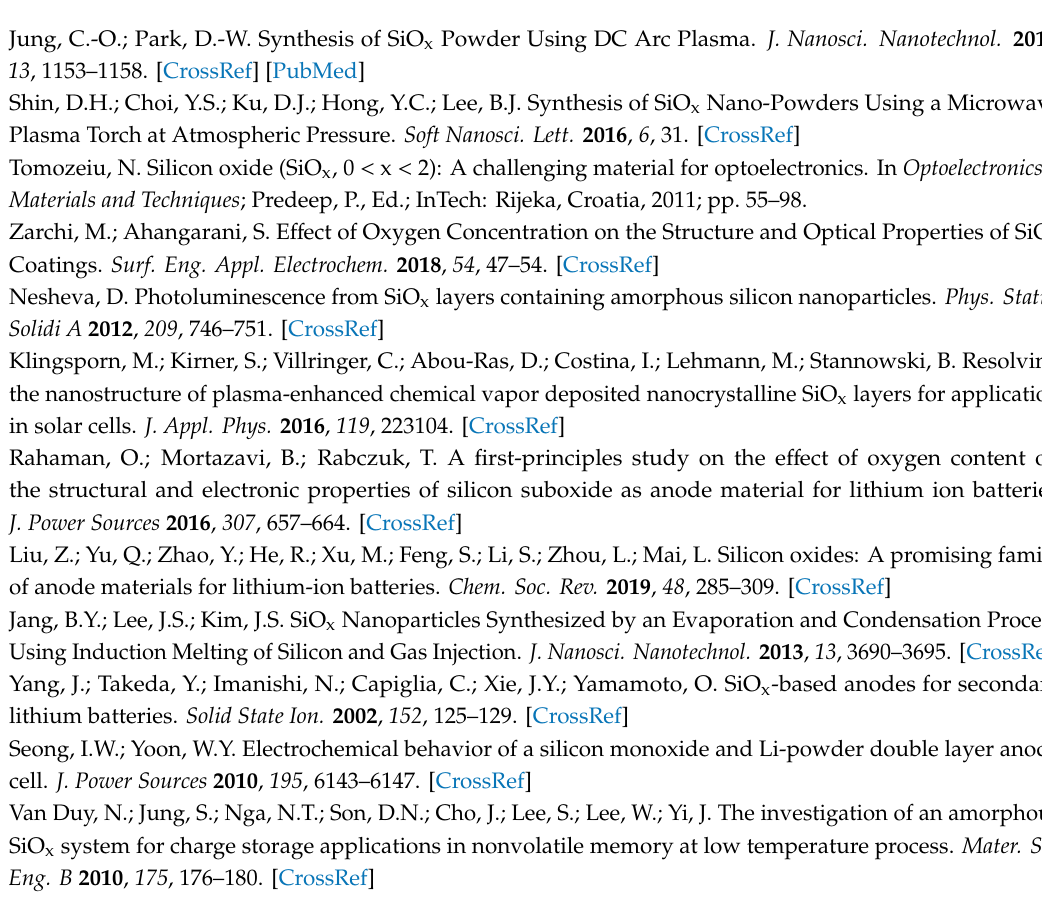
Figure S1: FESEM images and their high contrast counterparts of SiO x NPs synthesized at voltages of (a) 7.5 V, (b) 10.0 V, and (c) 12.5 V at a constant temperature of 5 ◦ C, Table S1: Wt% of the elements in SiO x NPs synthesized at voltages of (a) 7.5 V, (b) 10.0 V, and (c) 12.5 V at a constant temperature of 5 ◦